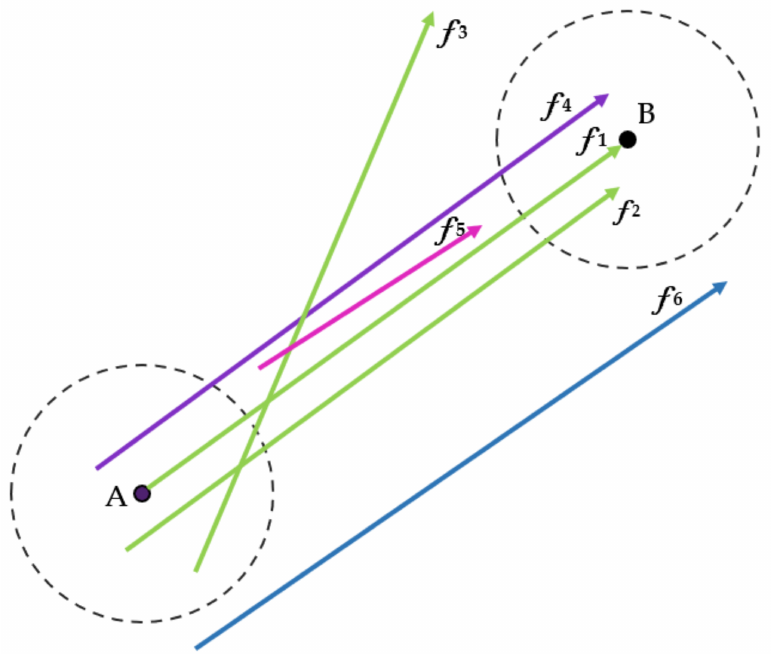
Figure 5. Illustration of similar and dissimilar flows. Different colors denote different activity semantics. Boundary circles identify all similar flows whose origin and destination points are within the circle. f 3 is dissimilar to f 1 in direction. f 4 is dissimilar to f 1 in activity semantic. f 5 and f 6 are dissimilar to f 1 in length. Only f 2 is similar to f 1